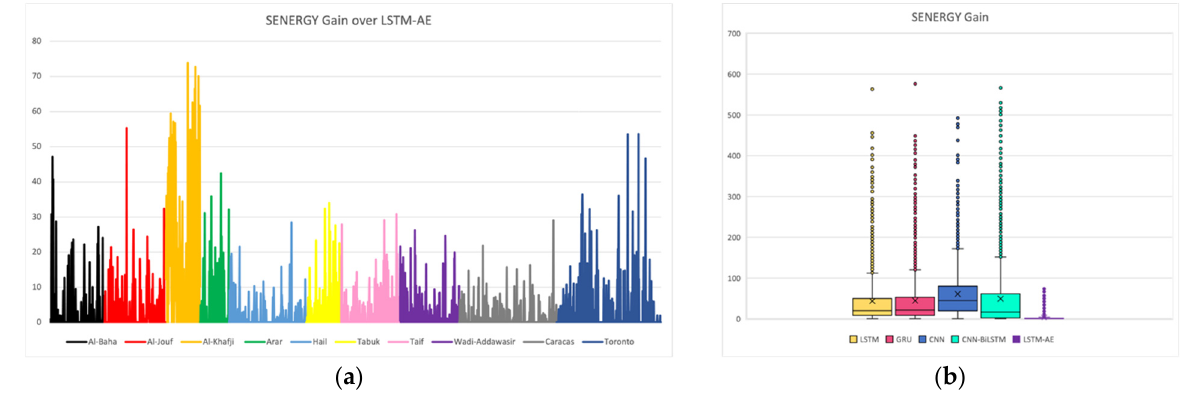
Figure 43. Gain of SENERGY: ( a ) over LSTM-AE; ( b ) as a boxplot for the five base models.